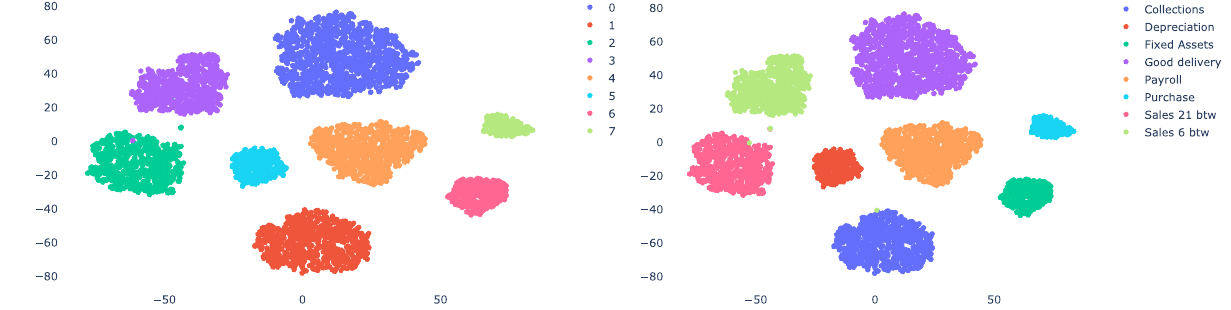
Figure 6. The t-sne visualization of the vector embeddings for the simulated data with the finWalk strategy. On the left you see the clusters as obtained by the agglomerative clustering algorithm and on the right you see the ground truth Cluster’s labels.